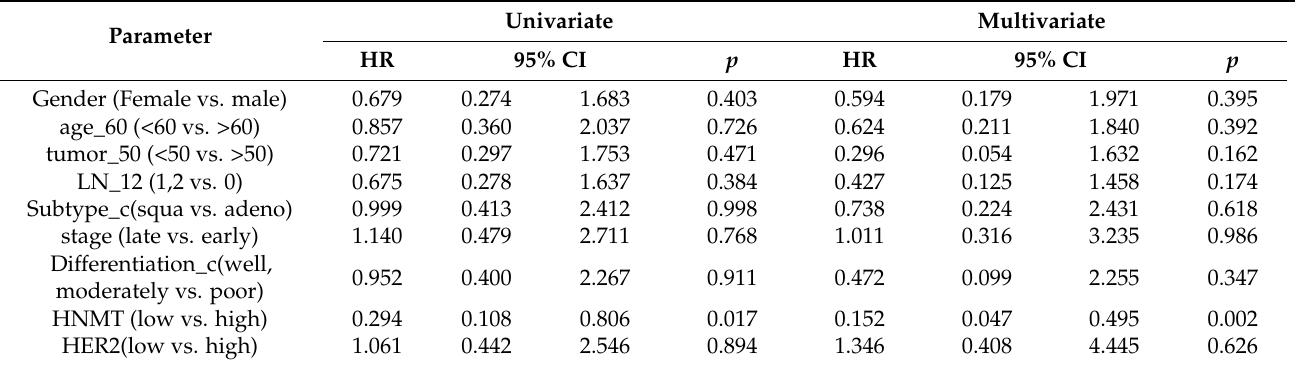
Table 2. Univariate and multivariate analysis of HNMT expression in the NSCLC